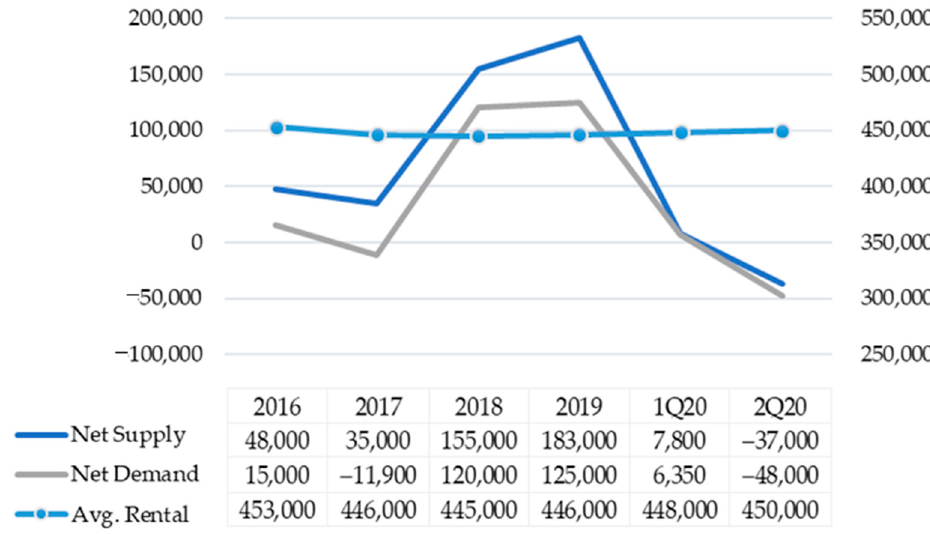
Figure 1 . Supply and demand retail property development in Indonesia.